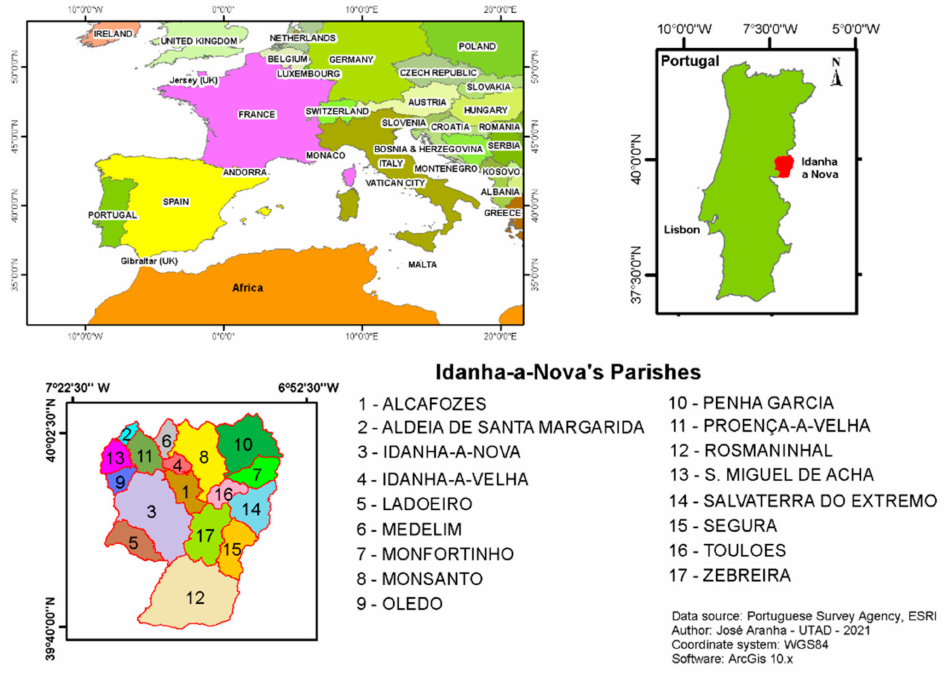
Figure 1. Study area